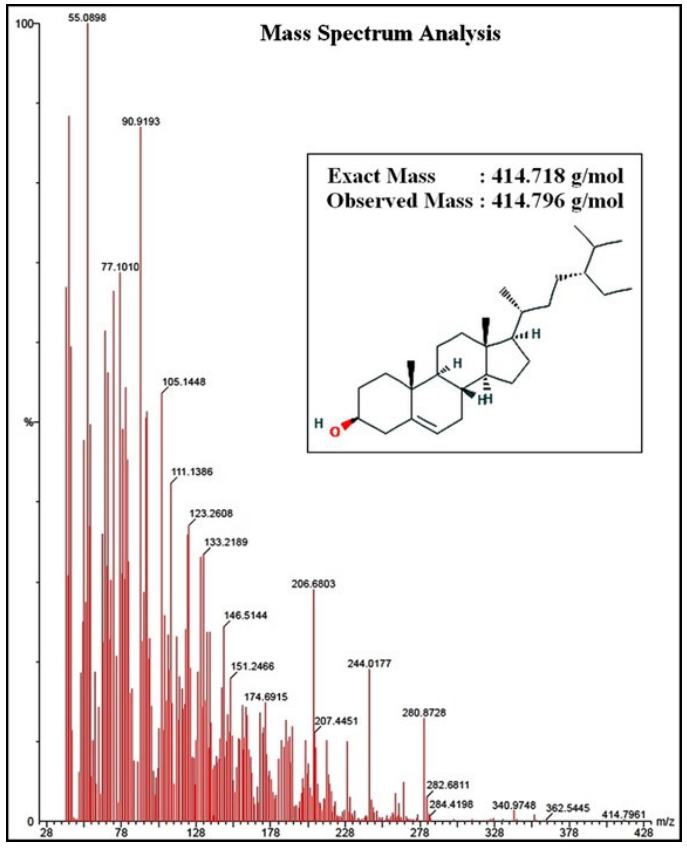
Fig. 5. Mass spectrometry analysis of pure compound that confirms its chemical structure as